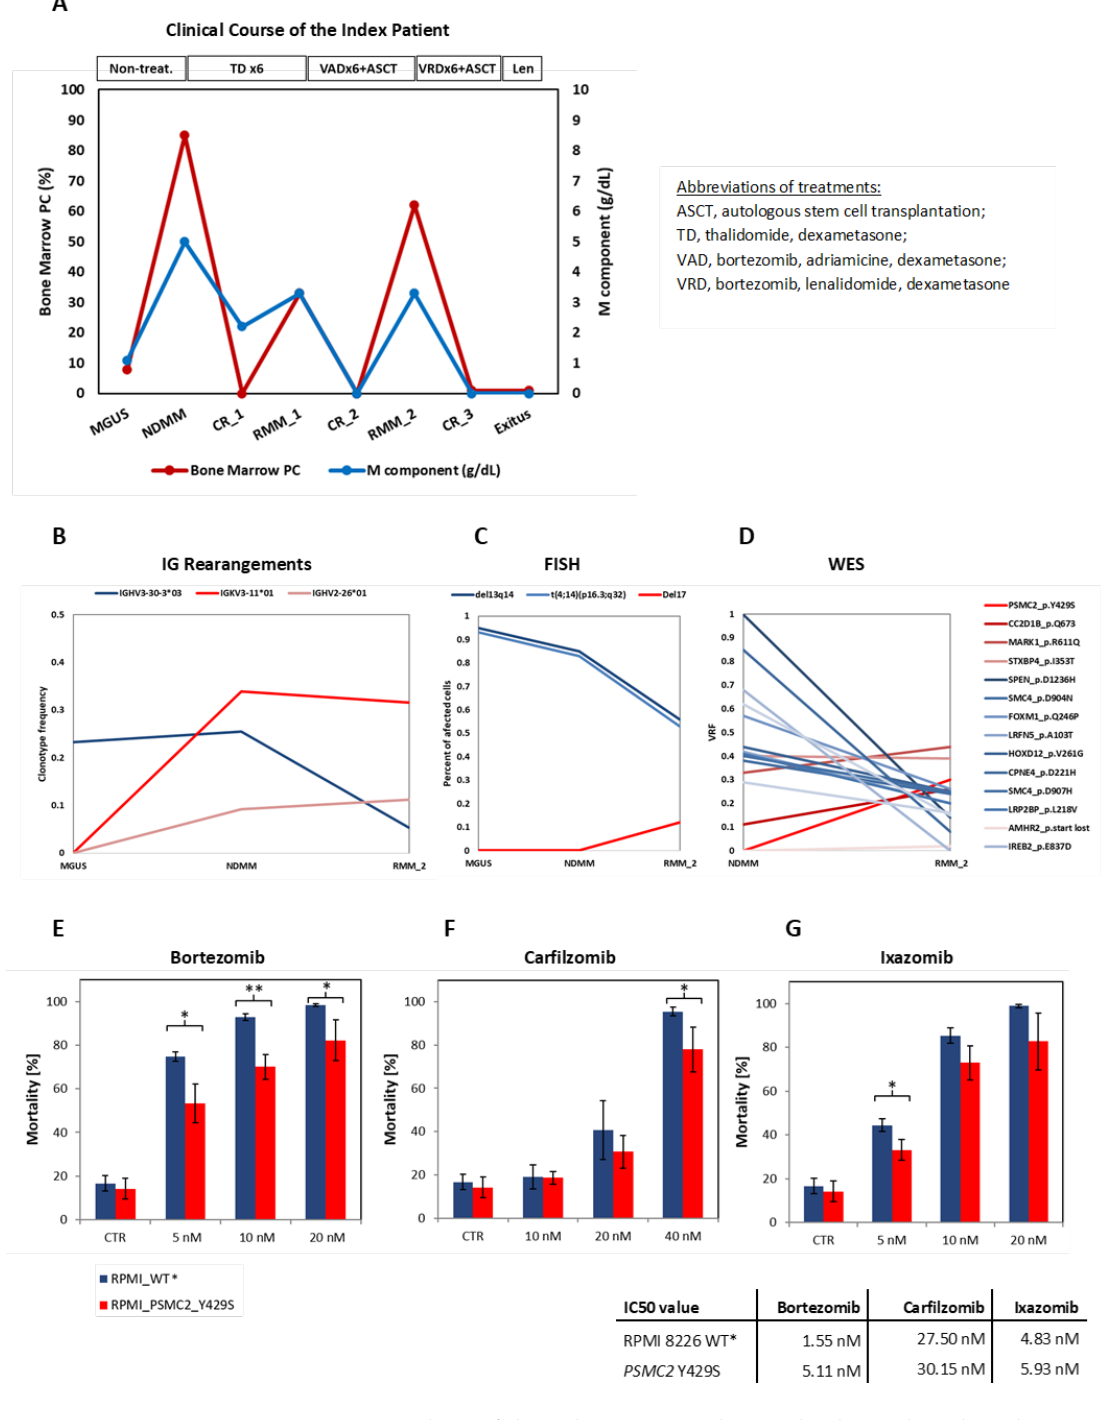
Figure 1. Deep analysis of the index patient in longitudinal samples: clinical course, treatment regimen, and sampling time points ( A ); oligoclonality by immunoglobulin sequencing ( B ); FISH ( C ); WES ( D ) and functional confirmation of the PSMC2 p.Y429S mutation ( E,F,G ). Cytotoxicity assay and IC50 values of the RPMI 8226 MM cell line harboring stably expressed PSMC2 p.Y429S mutation and the control (* RPMI 8226 transduced with the lentivirally encoded WT PSMC2).